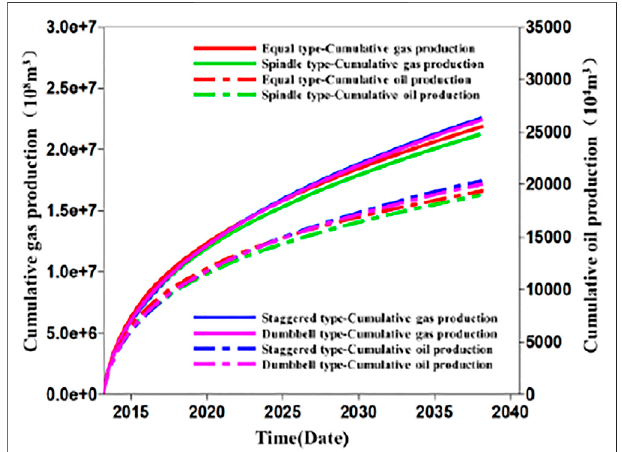
FIGURE 13 | Cumulative condensate/gas – time curves of different fracture laying